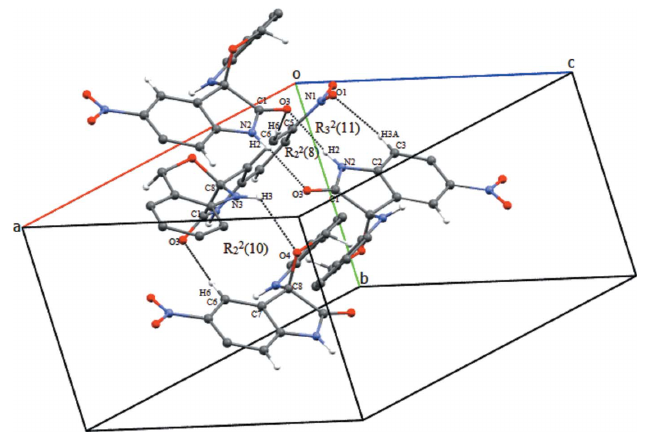
Figure 4 Aview of the hydrogen-bonded ring motif. Details of the hydrogen bonds are given in Table 1.